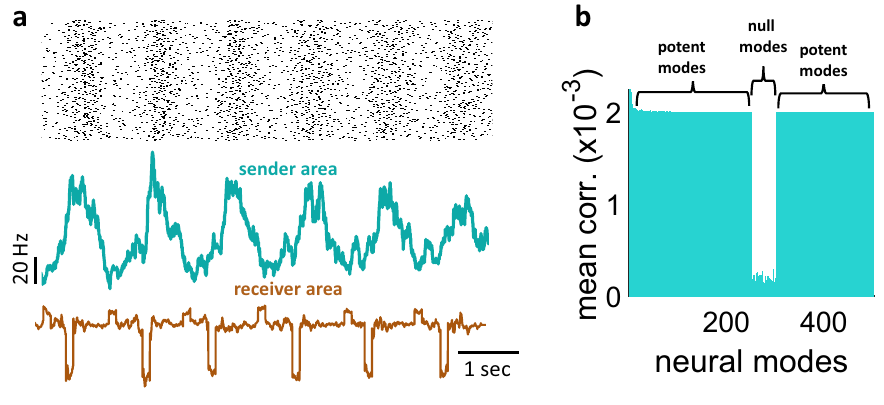
Figure 4. Propagating null and potent modes of neural activity in a spiking network. ( a ) Top: spike raster from a sender network ( N = 500 units) where a subset of modes (250 to 350 in rank) was set to null. Bottom: sum of population activity over time. ( b ) Correlation between modes of the sender and receiver areas.